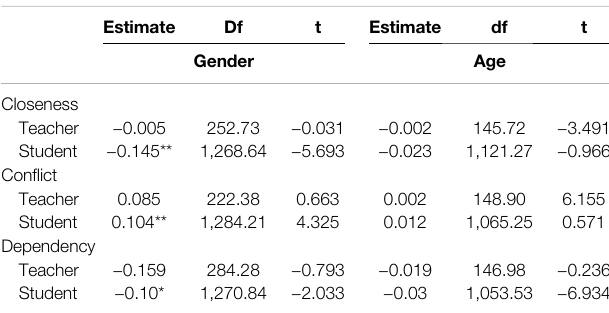
TABLE 4 | Results for the prediction of the STRS and CARTS